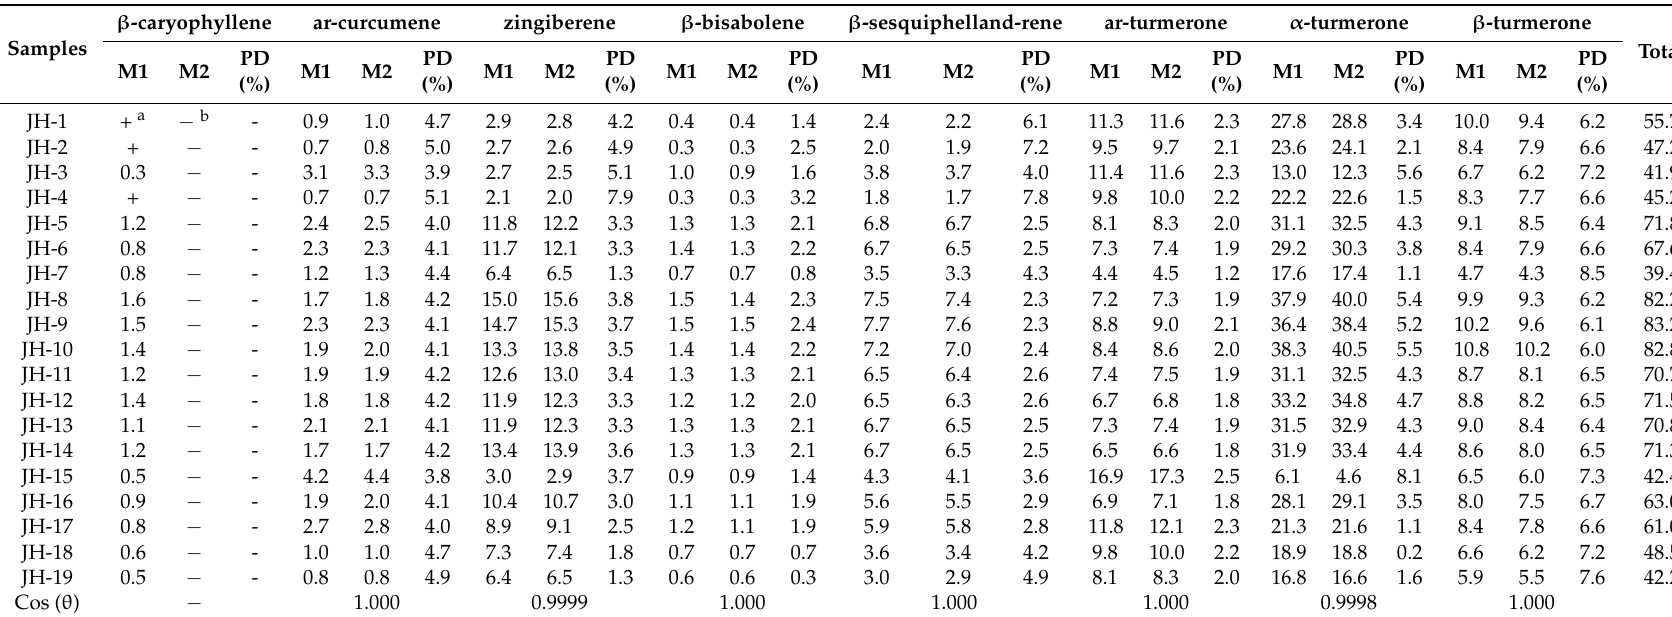
Table 5. Comparison for the contents (mg/g) of investigated components in C. longa calculated by individual reference compounds (M1) and STVCF calibration curves